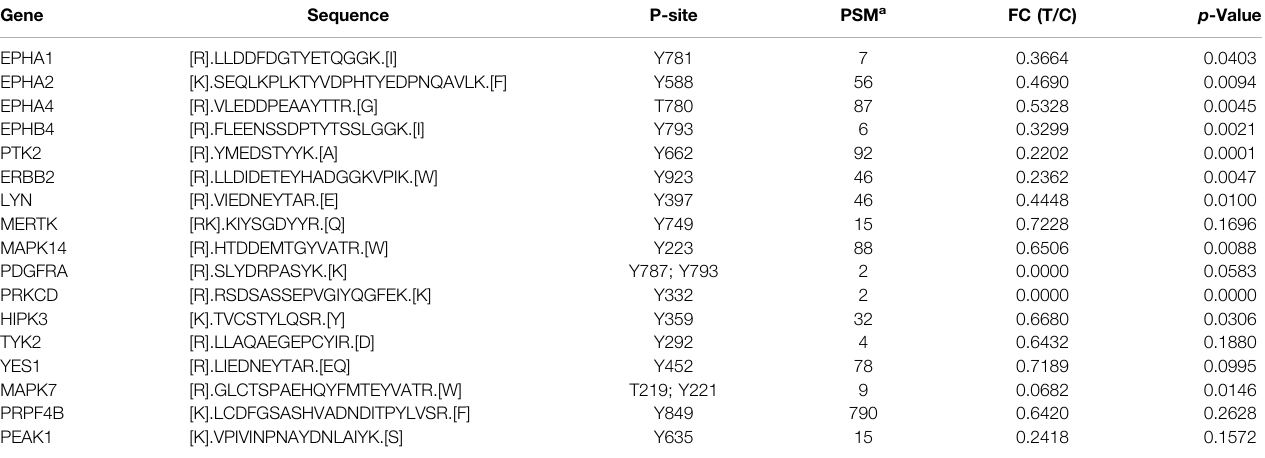
TABLE 1 | List of signi fi cantly altered tyrosine-phosphorylation of kinases upon inhibition of CAMKK2 in gastric cancer, which were not reported earlier to be regulated by CAMKK2.